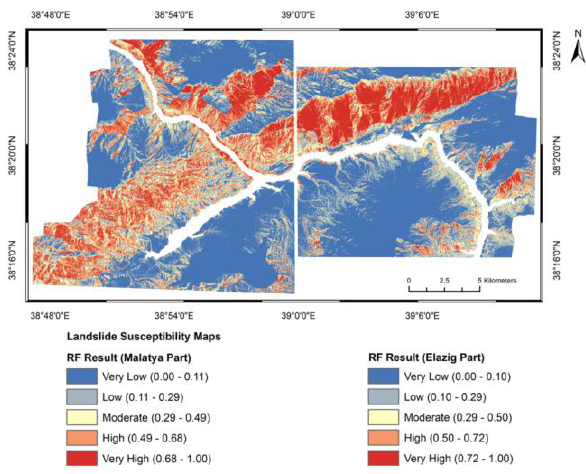
Figure 5. LSMs of the study area obtained with RF